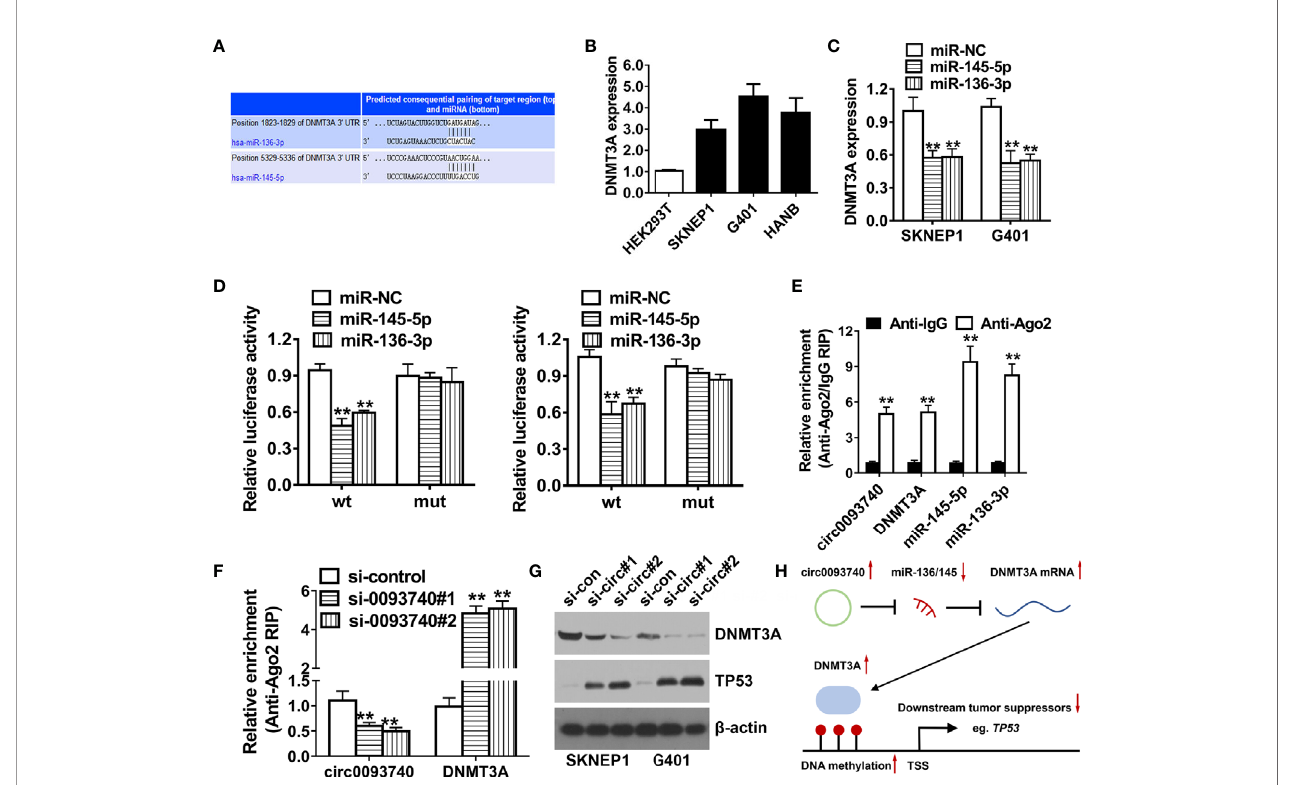
FIGURE 5 | circ0093740 facilitates Wilms tumor progression through circ0093740-miR-136/145-DNMT3A axis. (A) According to TargetScan online website, DNMT3A was the putative downstream target of both miR-136 and miR-145. (B) DNMT3A expression in Wilms tumor cell lines. (C) Expression of DNMT3A transcript was decreased after transfection with miR-136 and miR-145 mimics, detected by qPCR analysis. (D) Luciferase reporter assay of SKNEP1 and G401 Wilms tumor cells co-transfected with miR-136/145 mimics and the 3 ’ -UTR of DNMT3A wild type/mutant luciferase reporter. (E) Enrichment of circ0093740, DNMT3A and miR-136/145 on AGO2 assessed by RIP assay. (F) Enrichment of DNMT3A to AGO2 was increased after silence of circ0093740. (G) Knockdown of circ0093740 contributed to the reduction of DNMT3A protein expression in SKNEP1 and G401 Wilms tumor cell. (H) The molecular mechanism of Circ0093740 Facilitates Wilms Tumor Progression Through circ0093740-miR-136/145-DNMT3A Axis diagram. **p <